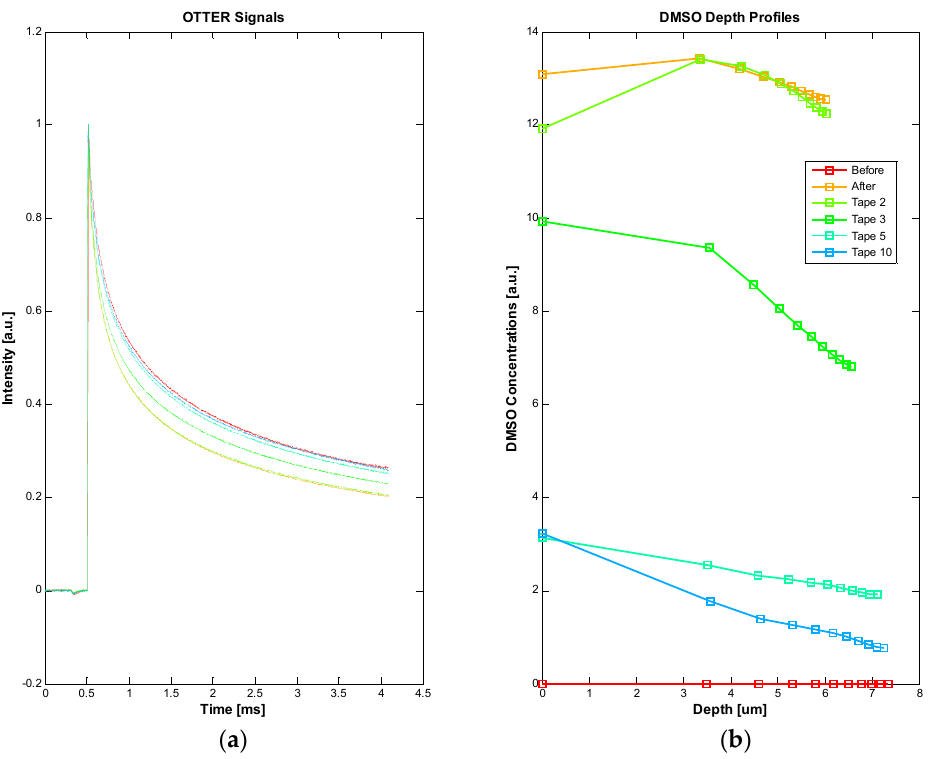
Figure 6. The OTTER signals of DMSO penetrating through skin ( a ) and the corresponding DMSO concentration depth profiles using SLS fitting technique after different tape stripping ( b ).